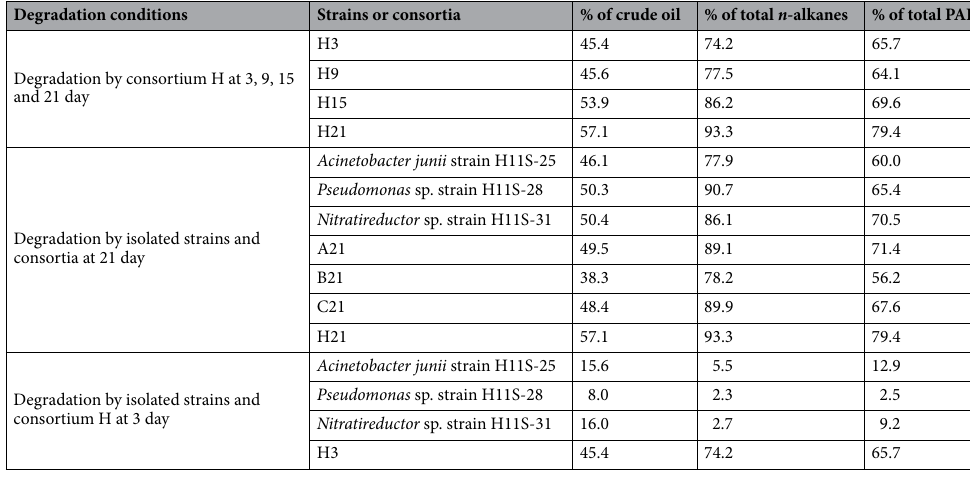
Table 4. Degradation efficiencies of crude oil, total n -alkane and PAHs by isolated strains or consortia at different day.